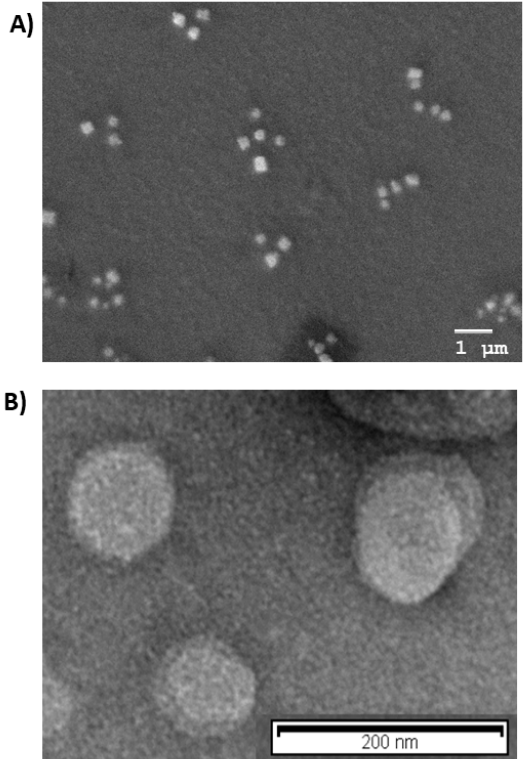
Figure 1. Morphological analysis: ( A ) Scanning electron microscopy (SEM) image of Cur-PNP; ( B ) transmission emission microscopy (TEM) image of Cur-SLN. DSC analysis was performed to evaluate the thermotropic behavior of Cur-loaded PNP and SLN. Figure 2a shows the thermogram of free Cur (A), PLGA (B), empty PNP (C) and Cur-PNP (D). Cur (A) presents a typical melting endotherm with onset temperature at 169.88 ◦ C indicating its crystalline nature. The absence of melting peak in curves B and C was due to PLGA which is amorphous in nature and showed its typical glass transition at 37 ◦ C [7,43]. Thermal analysis confirmed the encapsulation of Cur in PNP as demonstrated by the absence of Cur peak in the thermogram D that corresponds to Cur-PNP. In Figure 2b the DSC curves of SLN counterpart are shown. Curve F shows the endothermic peak of Softisan with onset temperature at 37.96 ◦ C, while, Lutrol F68 thermogram shows an onset temperature of 51.87 ◦ C (C). Both peaks suffer a slight shift in empty and loaded SLN at 44.49 ◦ C and 73.91 ◦ C, respectively, in the unloaded SLN and at 42.73 ◦ C and 72.89 ◦ C in